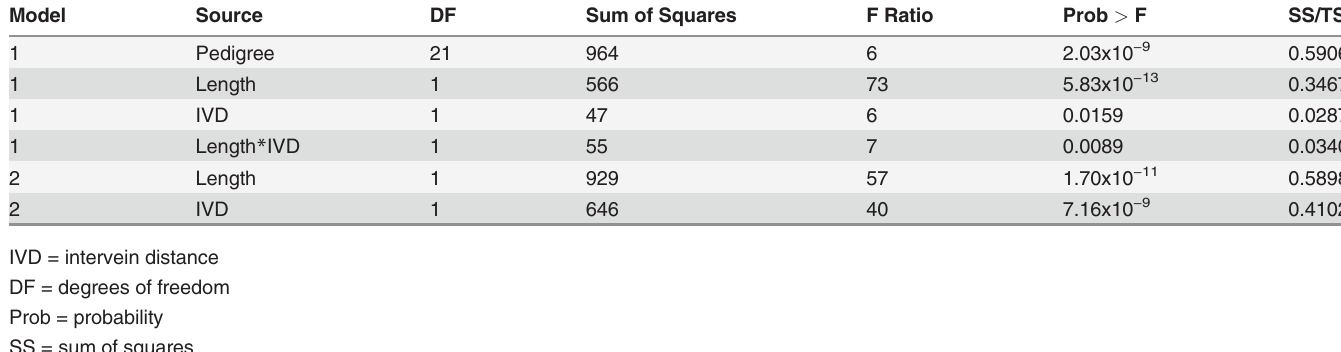
Table 6. Model results with conidiophore count (square root) as the response variable and lesion parameter predictors.